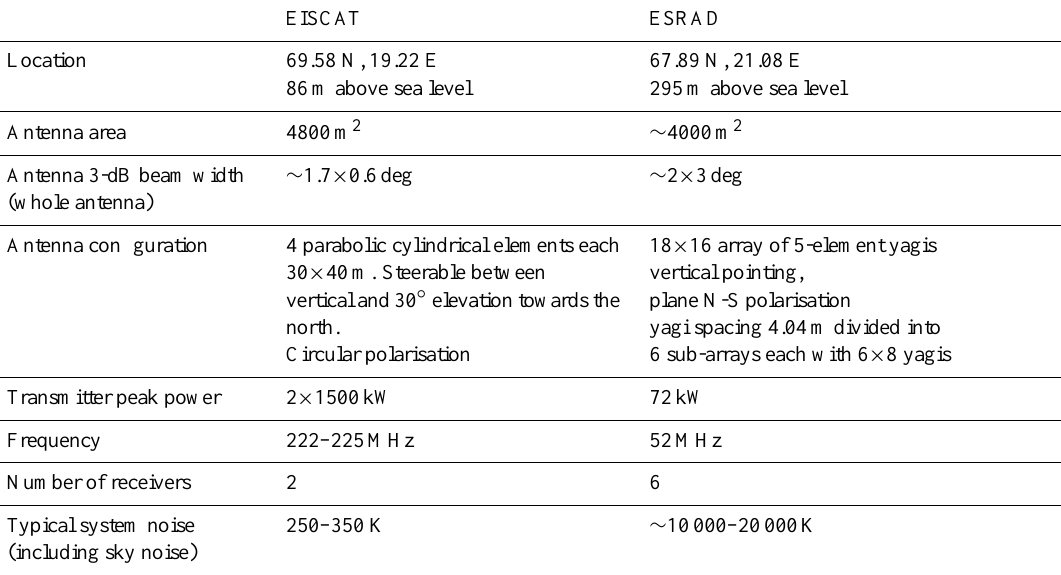
Table 1. ESRAD and EISCAT VHF radar characteristics. Antenna sizes and apertures are given in order (zonal dimension, meridional